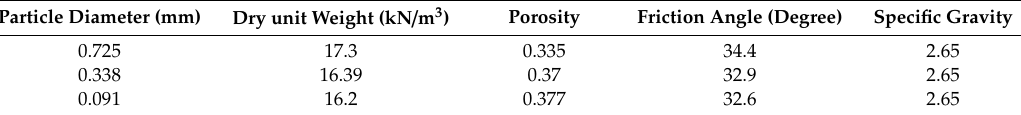
Table 1. Physical properties of sand specimens.